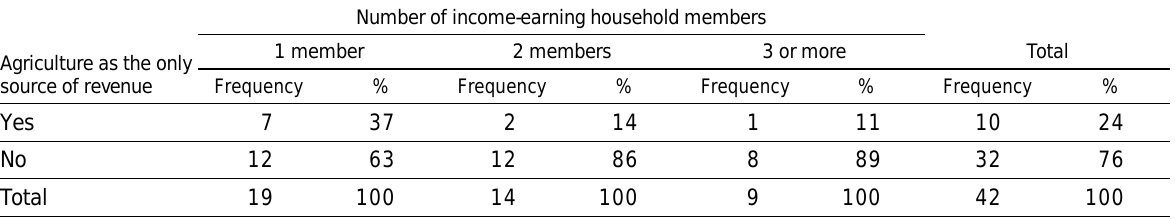
Table 5. Number of Household Income Earning Members and Agriculture as Only Source of Revenue